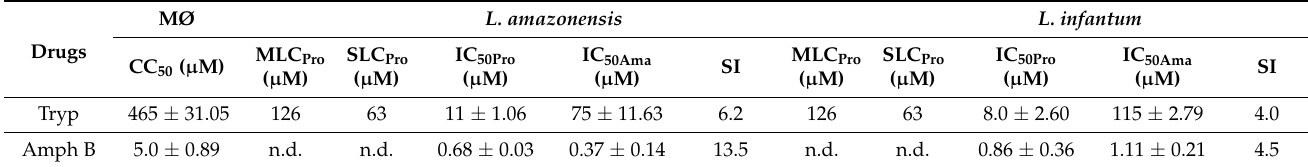
Table 1. Inhibition effects and cytotoxicity of tryptanthrin alkaloid. The results are expressed as a mean ± standard error of at least two independent experiments. Amphotericin B was used as a reference drug in the treatment of amastigote-infected